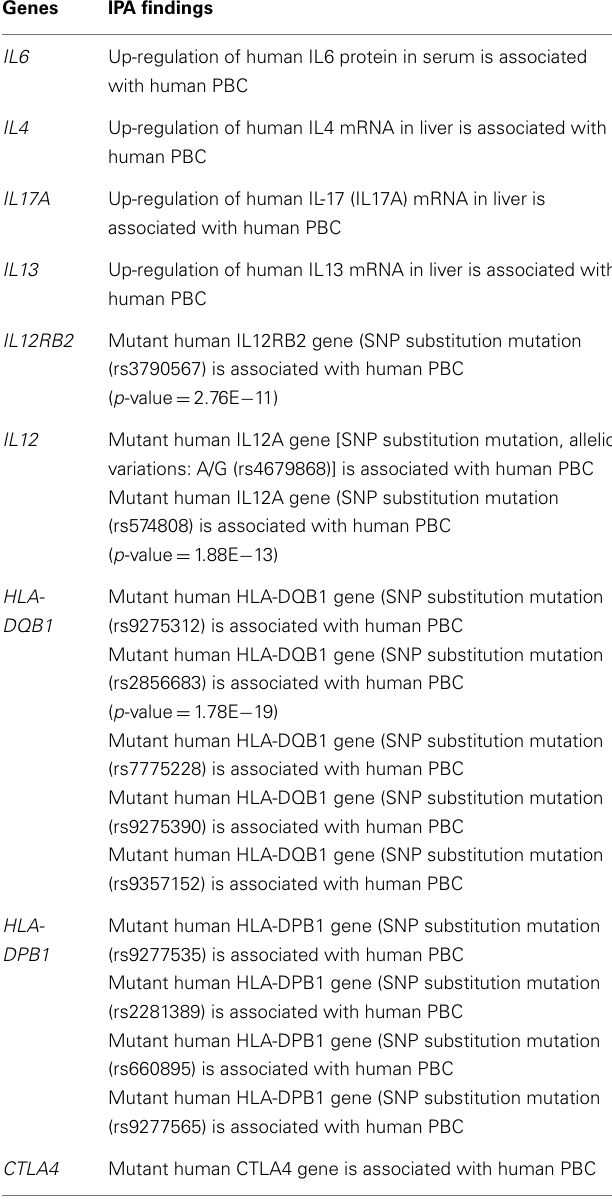
Table 4 | List of PBC-associated genes analyzed with ingenuity pathways analysis software 8.0